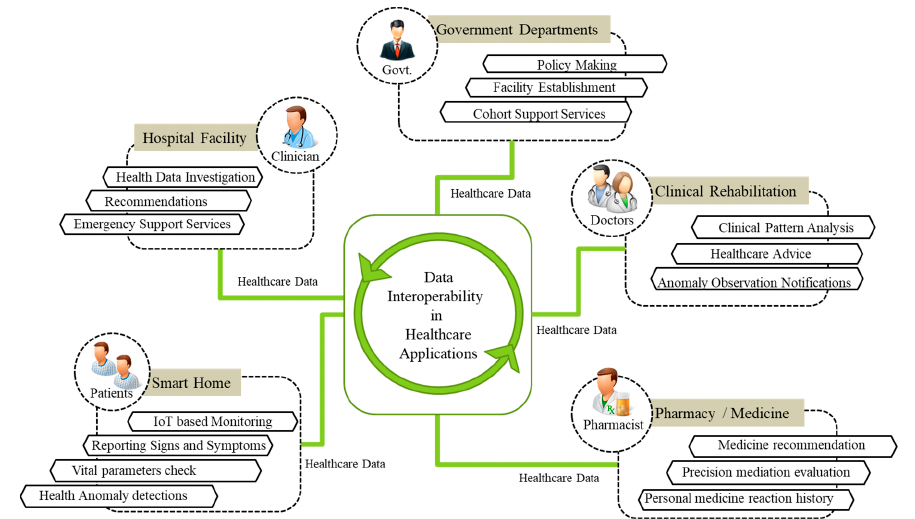
Figure 1. A view of the data interoperability in heterogeneous healthcare service environments.